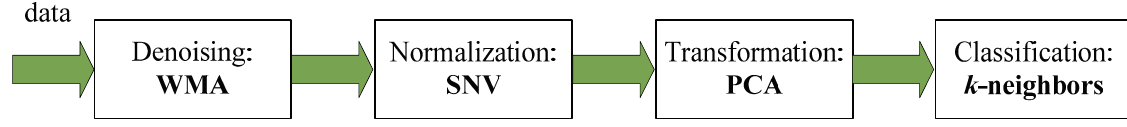
Figure 12. Optimal algorithms for the four-step signal-processing chain designed to deal with low-accurate narrowband fluorescence